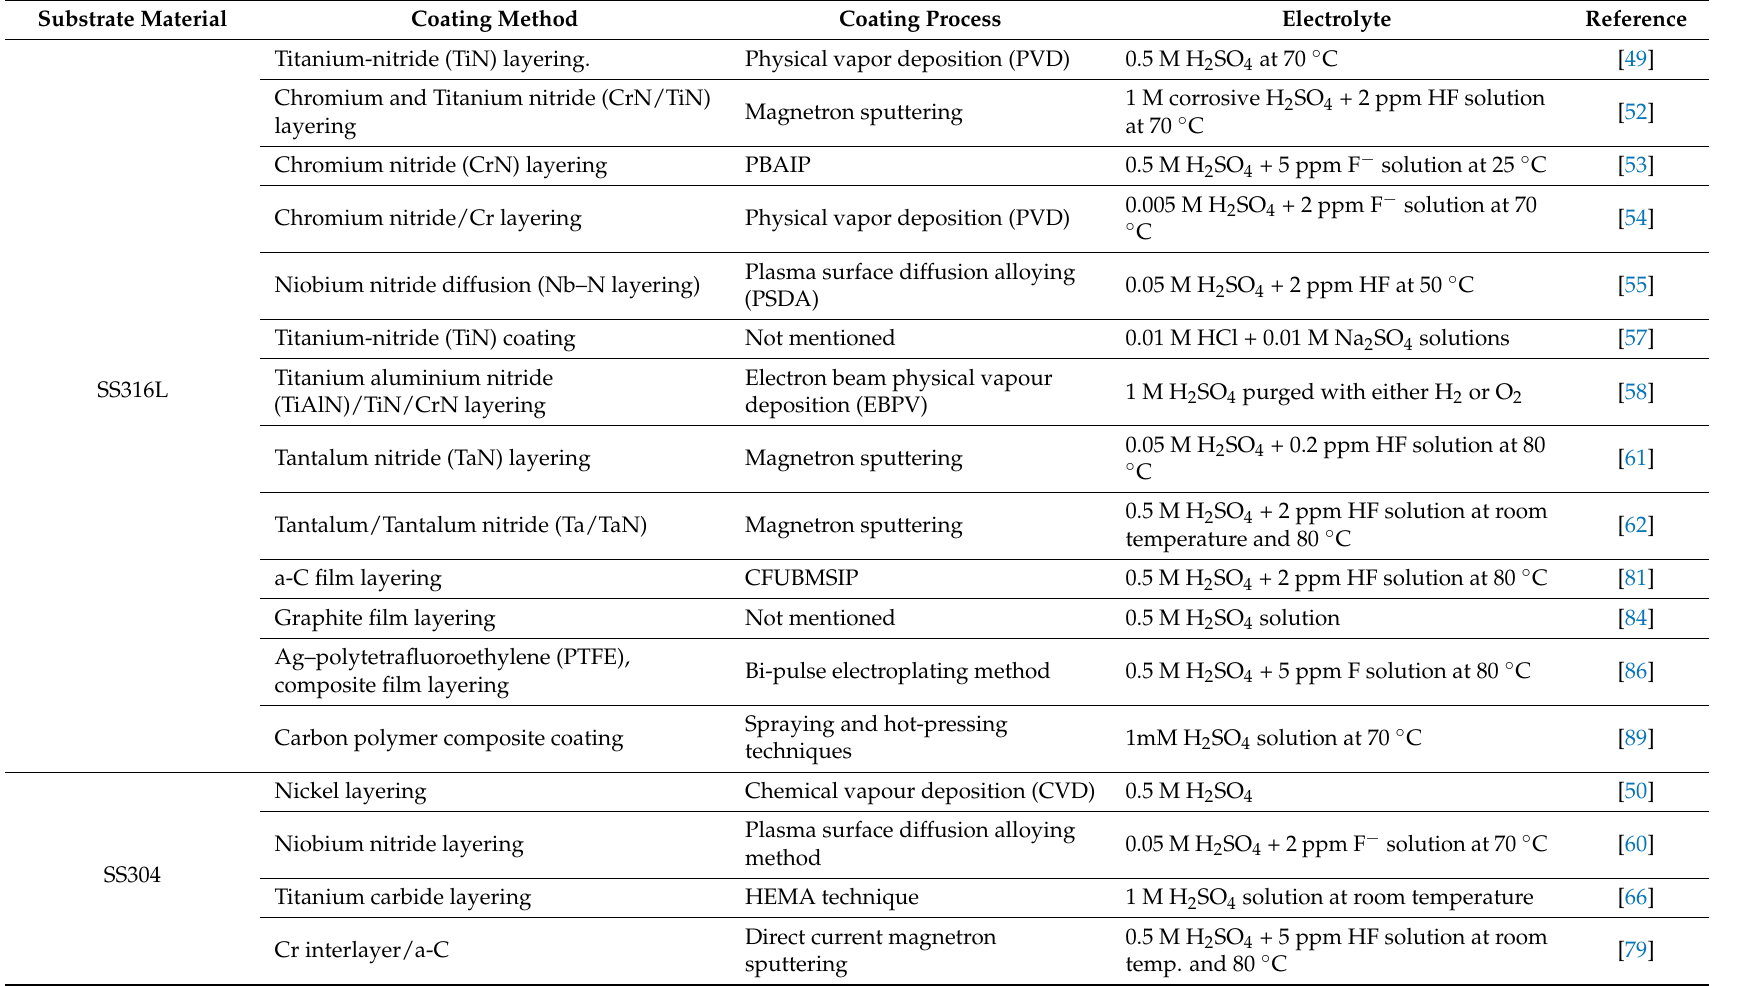
Table 4. Summary of techniques for coating bipolar